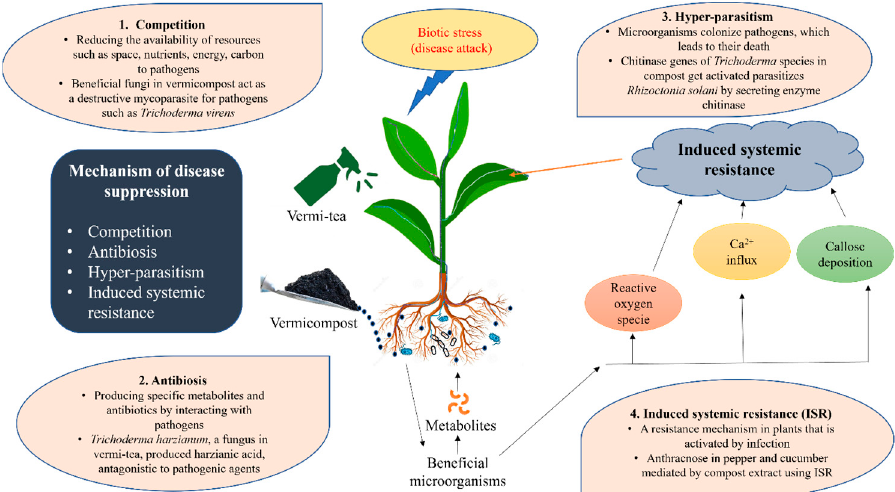
Figure 4. Mechanisms of disease suppression in plants using vermicompost and its derivative (vermi-tea). Vermicompost boosts microbial diversity and activity in the rhizosphere. These microbes protect plants by inducing systemic resistance against phytopathogens, increasing nutrient competition, releasing specific metabolites against pathogens, and directly parasitizing phytopathogens through various mechanisms.